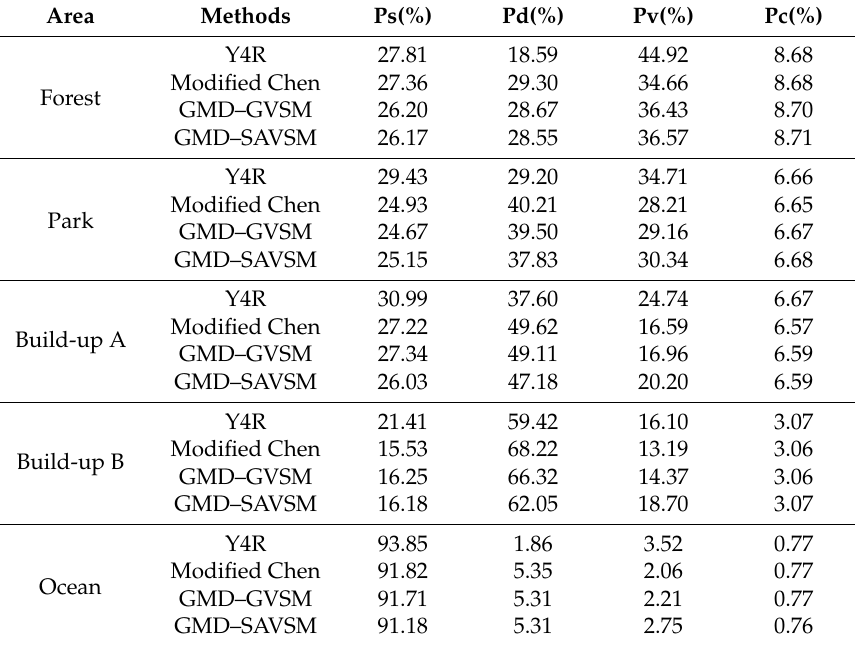
Table 3. Statistics of power of scattering components in selected areas of L-band AIRSAR image with different land cover